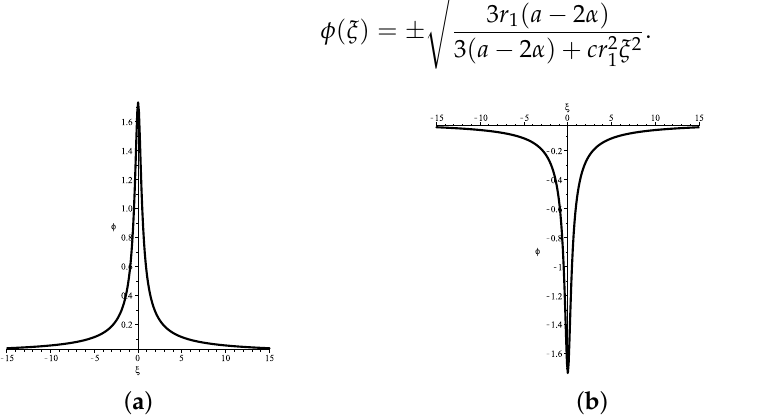
Figure 10. Solitarywave forms of system (5). ( a ) Bright solitary wave derived by (21) + . ( b ) Dark solitary wave derived by (21) −